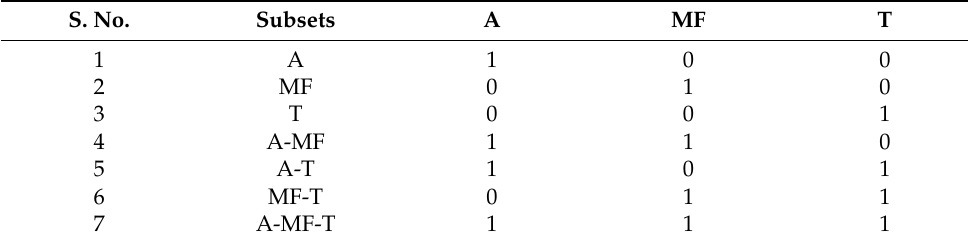
Table 3. Determination of the subsets.